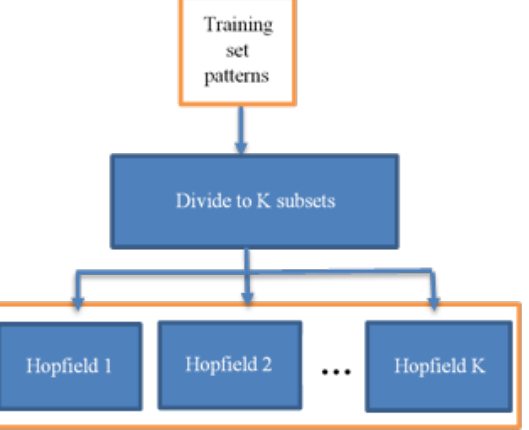
Figure 6. Block diagram of the multi-RNN architecture proposed in the training phase [52].